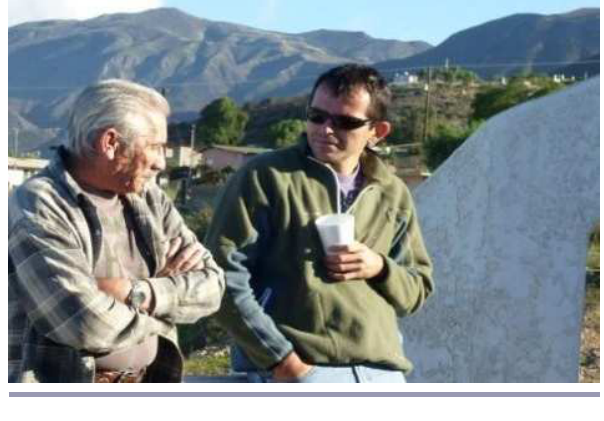
Fig. 11. Ethnographic research in the ejido.